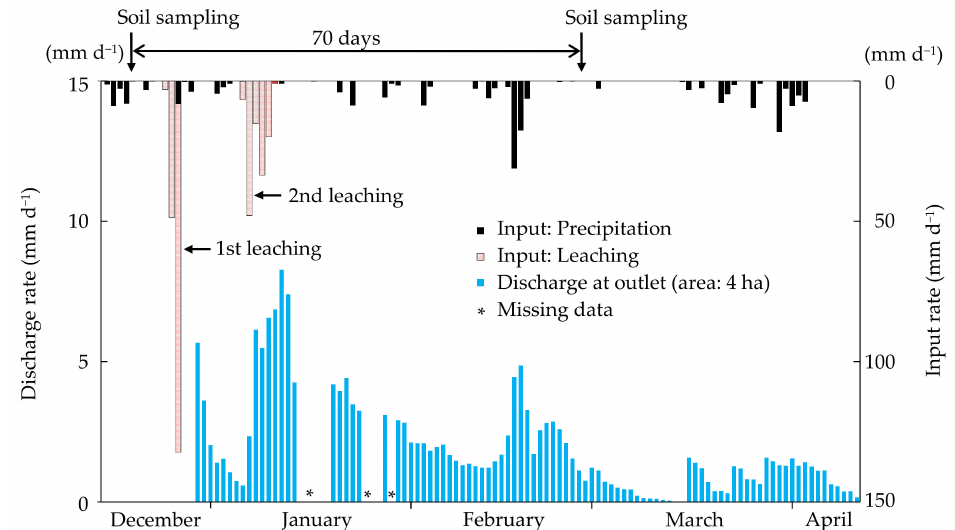
Figure 7. Amounts of discharged water and input water in the SSDC field. The horizontal axis is date and the upper side shows the input water for leaching and precipitation and the lower shows the discharged water from the SSDC outlet. The asterisks indicate missing data in the discharged